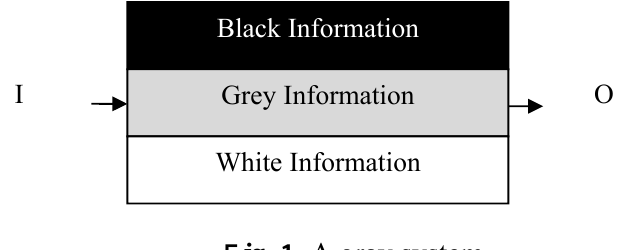
Black Information I Grey Information White Information F Fig. 1. A gray system